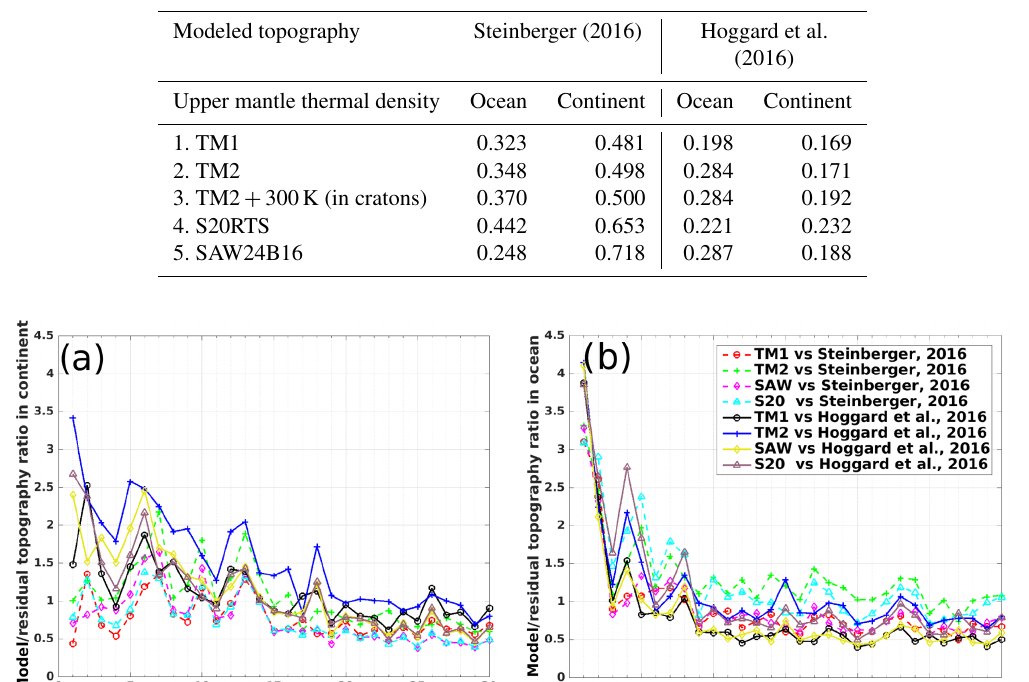
Table 1. Correlation between the modeled dynamic topography and the observation-based residual topography models (Steinberger, 2016; Hoggard et al., 2016) for continents and oceans.